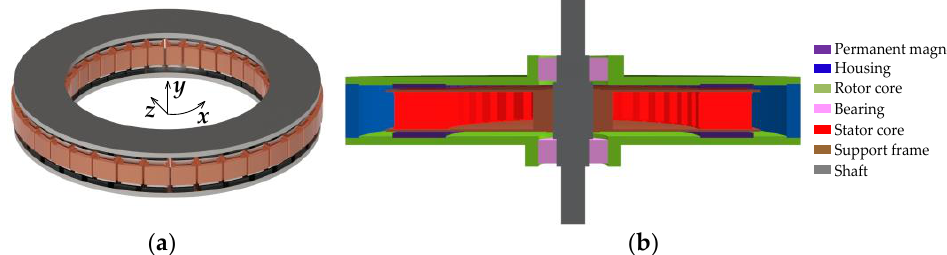
Figure 2. Structure of the YASA machine: ( a ) 3-dimensional structure; ( b ) view of the cross-section.